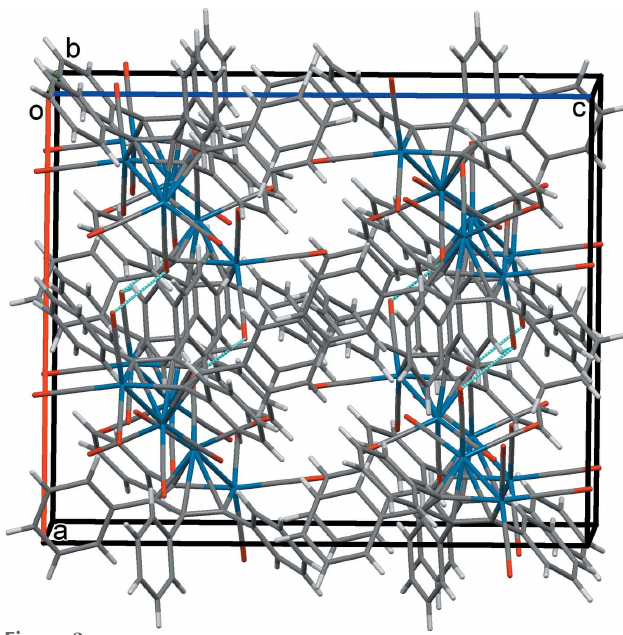
Figure 3 The overall packing of III , viewed along the b -axis